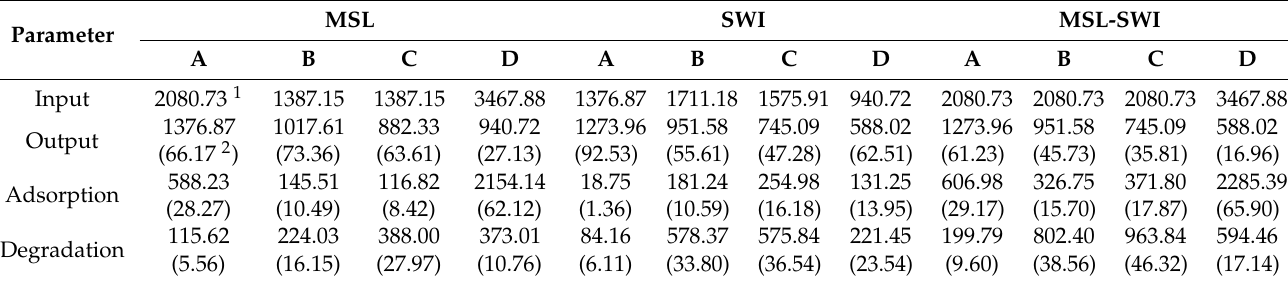
Table 3. Mass balance of nitrogen in MSL-SWI